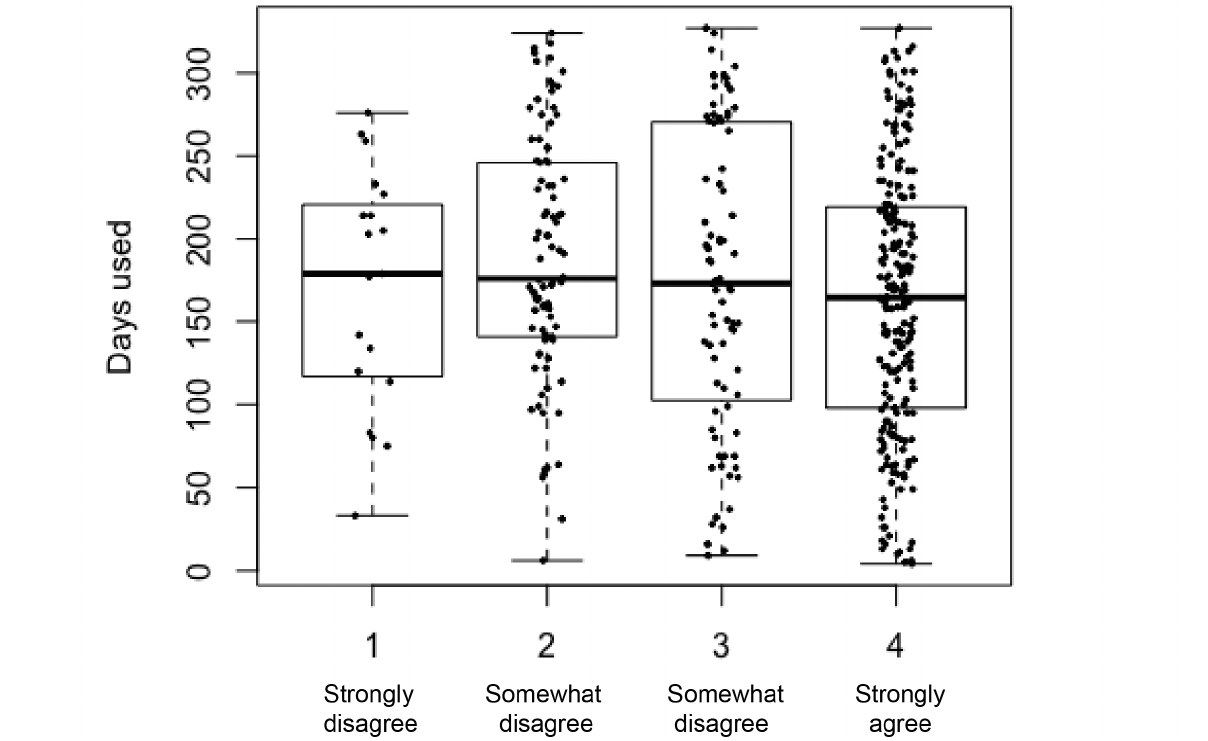
Figure 12. Boxplots of the distributions of having the goal to change eating habits. The stronger the goal, the less sustained use of the tracker.